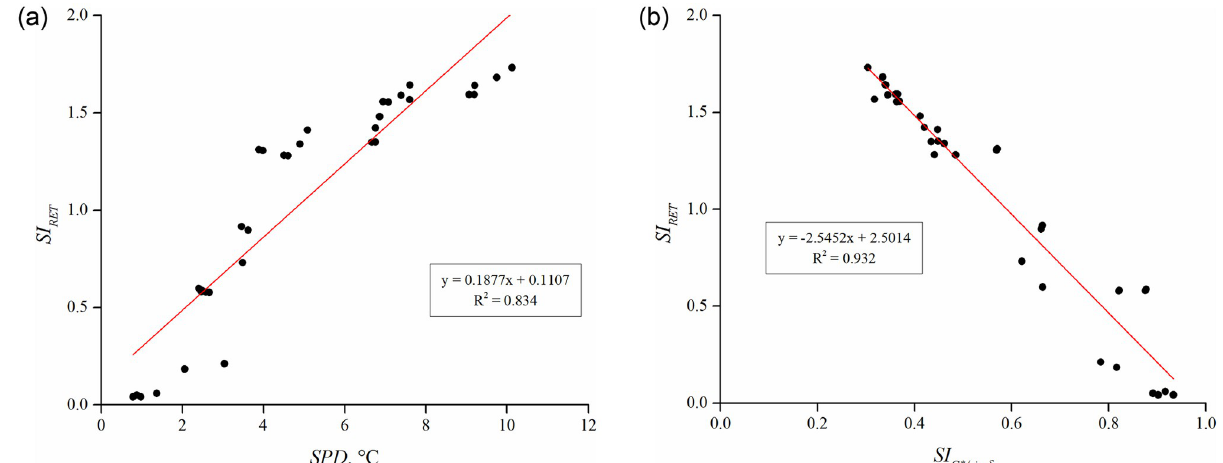
Fig 14. SI RET as a function of (a) SPD and (b) SI G * /sin δ .